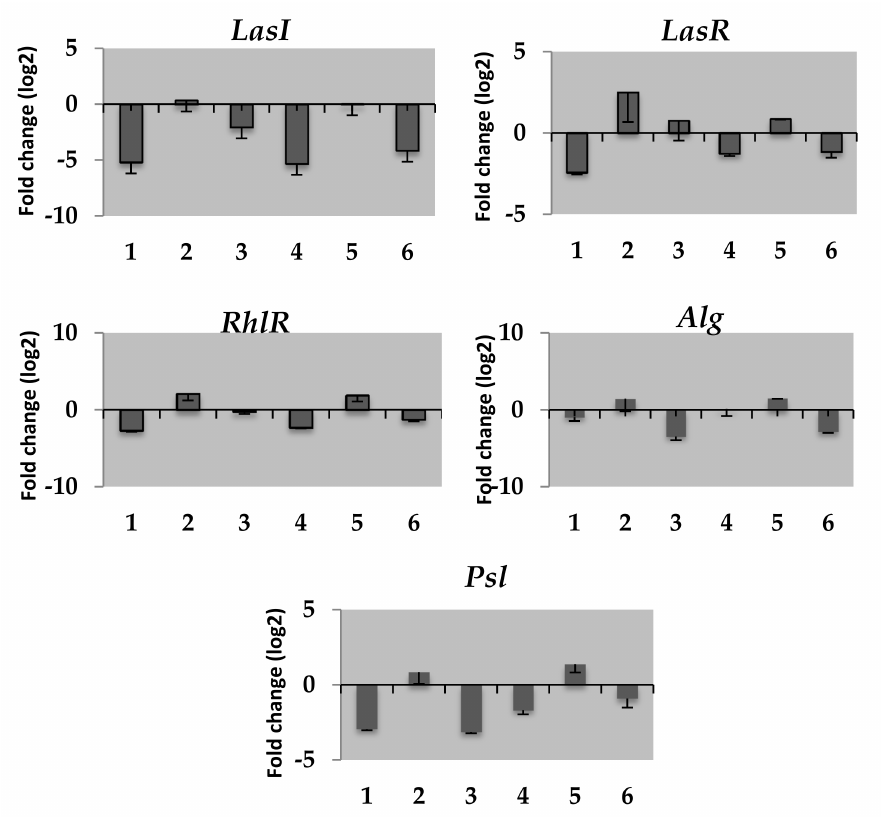
Figure 3. The mean relative mRNA expression levels of quorum sensing genes in P. aeruginosa cells treated with ciprofloxacin alone and in combination with curcumin, cinnamaldehyde, baicalein and esculetin hydrate. *Indicates statistically significant ( p < 0.05) 1. Ciprofloxacin (0.5 µ g/mL), 2. Ciprofloxacin (0.5 µ g/mL) and Baicalein (4 µ g/mL), 3. Ciprofloxacin (0.5 µ g/mL) and Curcumin (4 µ g/mL), 4. Ciprofloxacin (1 µ g/mL), 5. Ciprofloxacin (1 µ g/mL) and Esculetin hydrate (8 µ